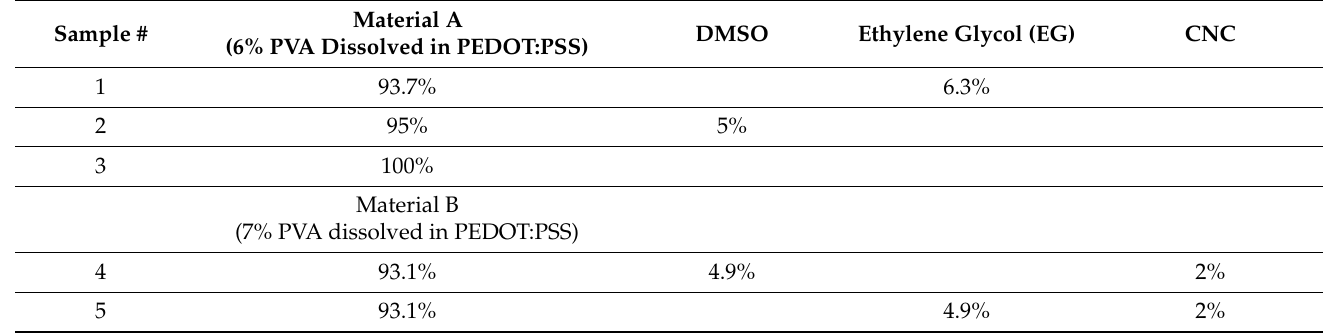
Table 1. Polymer solution composition. Unit: wt.%.